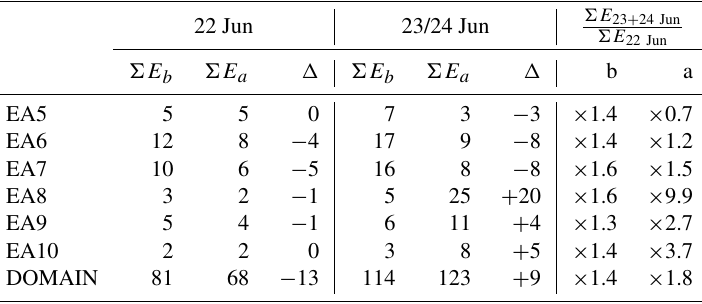
Table 6. Total anthropogenic emissions for EAs and domain-wide during the 22 and 23/24 June inversions (averaged for a 24h period). The posterior for 23/24 June is from an inversion using both the IMPROVE and ARACTAS-CARB observations. Results shown are for the FINN_STD scenario. Absolute units are in Mg. Note that the differences ( (cid:49) ) may not sum due to